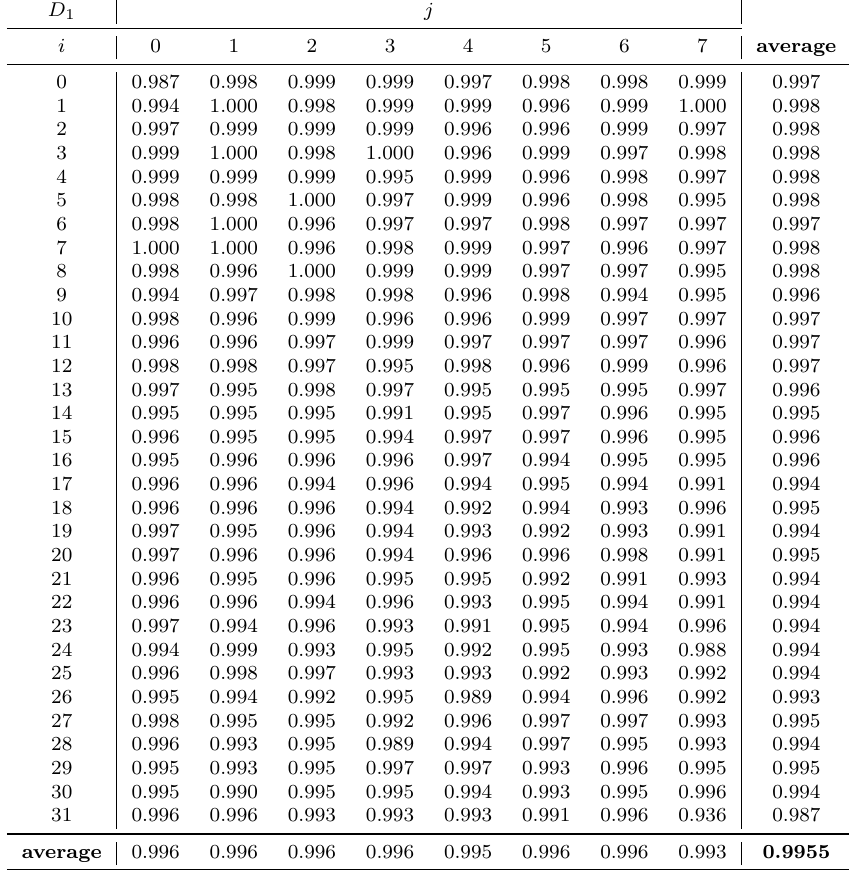
Table 19: Empirical probability to recover the message bit m [8 i + j ] from a single trace using both points. Average results for 1K traces from device D 2 . D